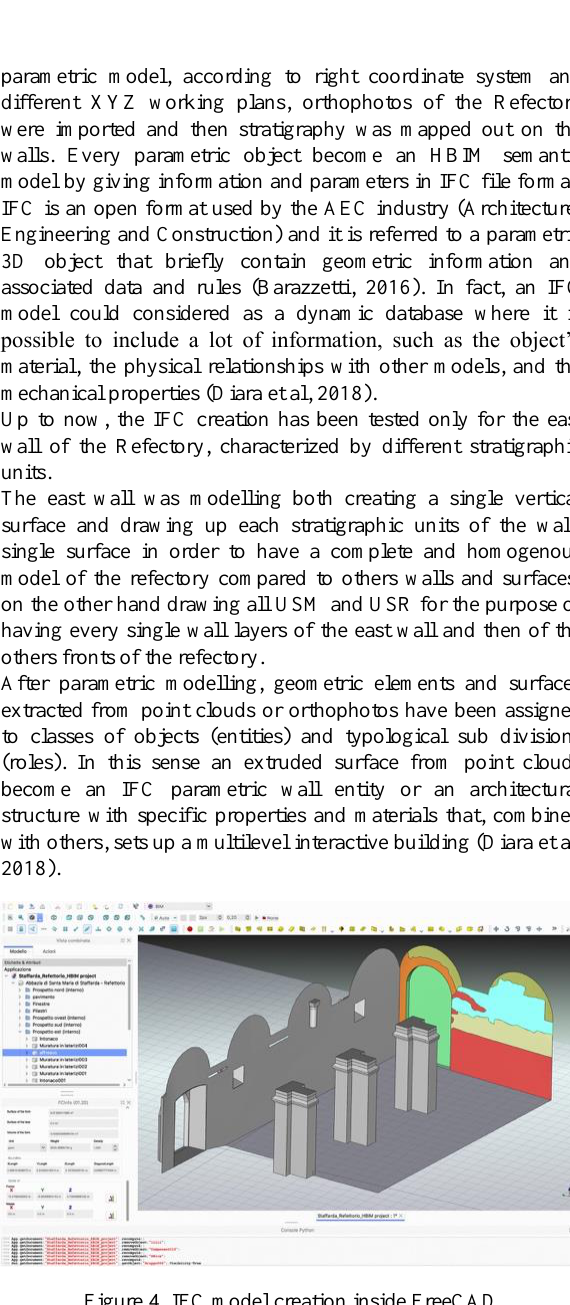
Figure 4. IFC model creation inside